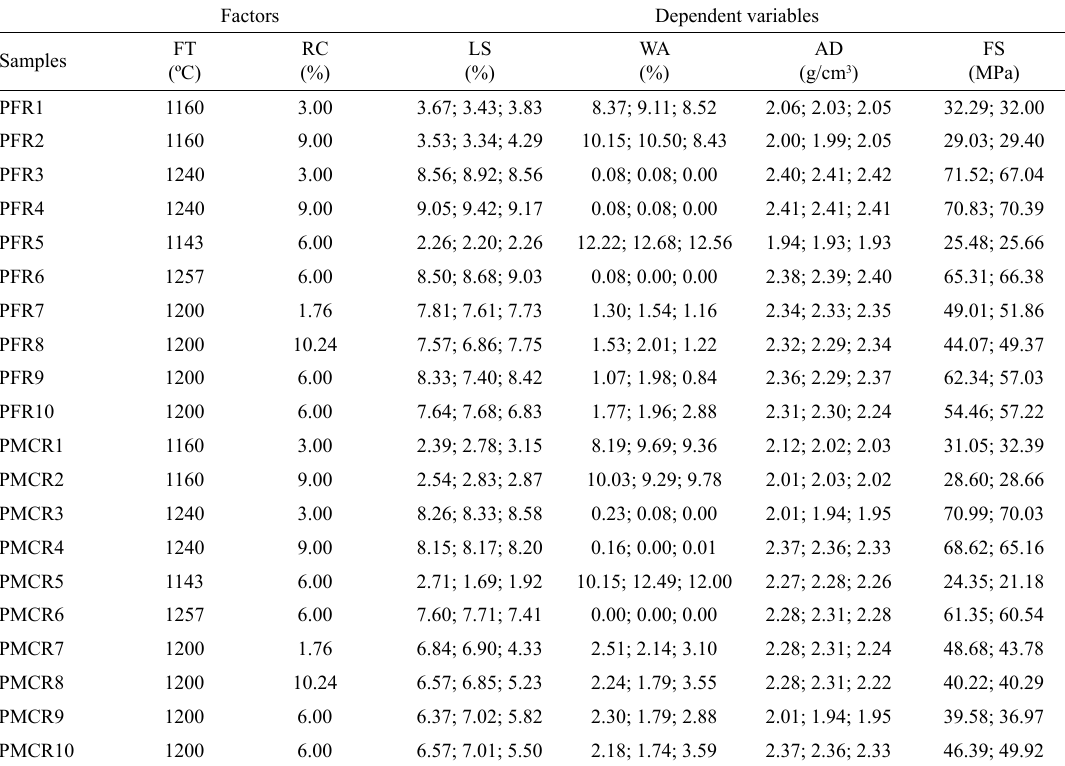
Table 4. Values of linear shrinkage (LS), water absorption (WA), apparent density (AD) and 3-point flexural strength (FS), obtained for compositions with fine quartzite residue (PFR) and compositions with milled coarse quartzite residue (PMCR). Factors Dependent variables